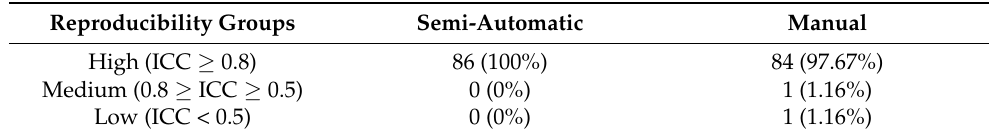
Figure 7. Correlation heatmap between observers.